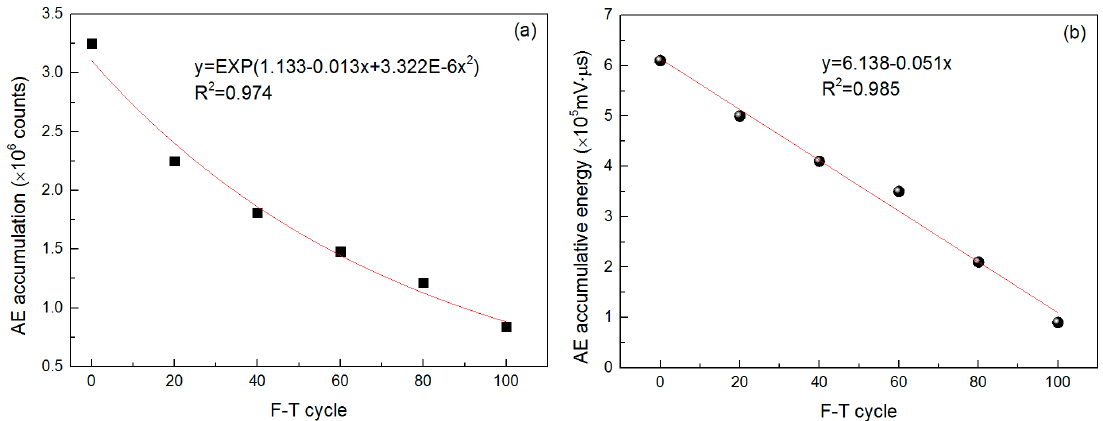
Figure 18. Plots of the AE accumulative counts ( a ) and the AE accumulative energy ( b ) against the freeze–thaw cycles.